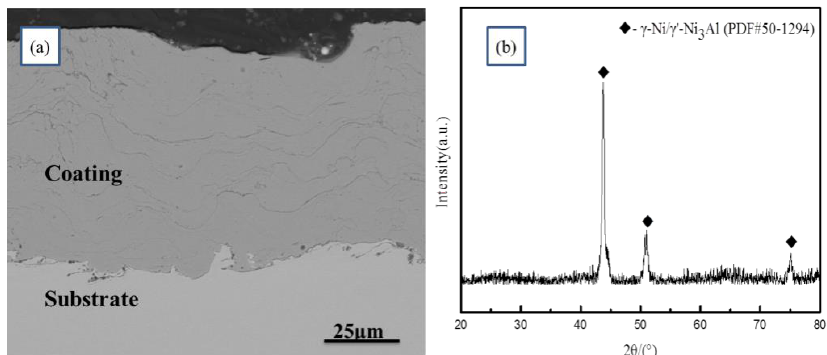
Figure 1. Cross-sectional back-scattered electron (BSE) image and X-ray diffraction (XRD) diagram of as-deposited coating: ( a ) cross-sectional BSE-images, ( b ) XRD diagram.